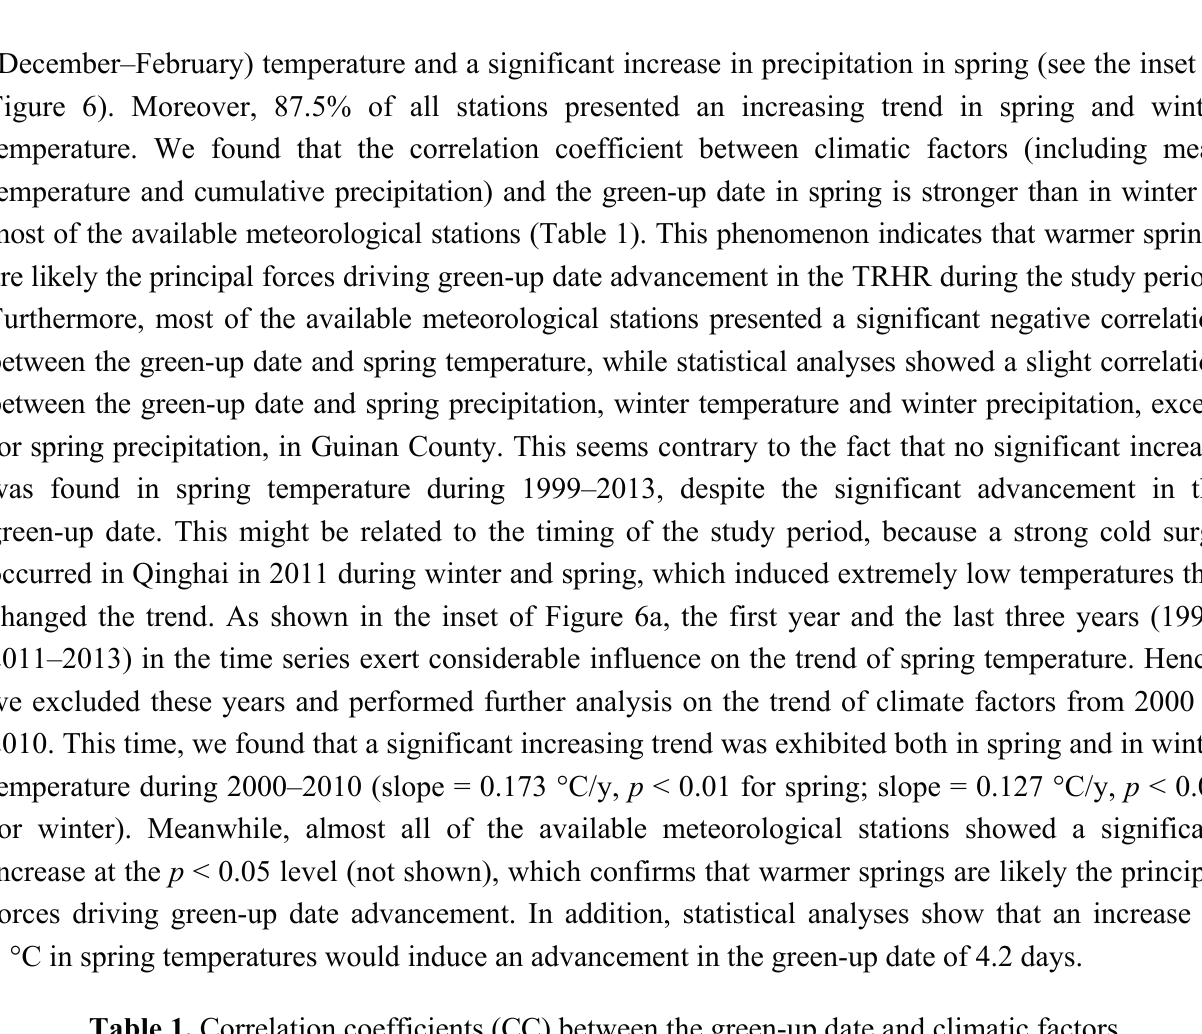
Table 1. Correlation coefficients (CC) between the green-up date and climatic